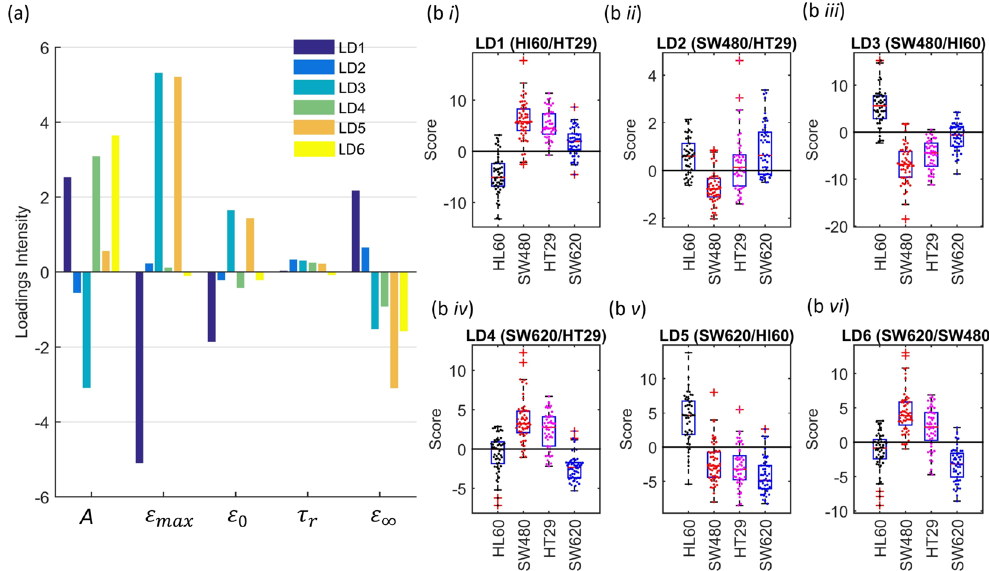
Figure 5. Linear discriminant analysis of the four cell lines; HL60, SW480, HT29 and SW620. Where the bar plot indicates the loadings for each of the linear discriminats (LD) ( a ), and the box plots and beeswarm plots on the right correspond to the scores on each of the LDs ( b i-vi).